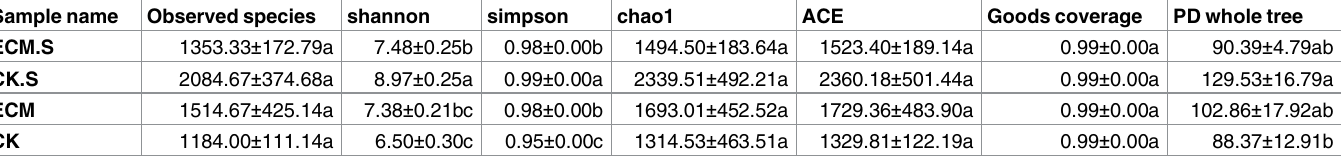
Table 1. Community richness and diversity indices of bacteria associated with Pinus armandii roots and surrounding soils with or without Tuber indicum partner. Sample name